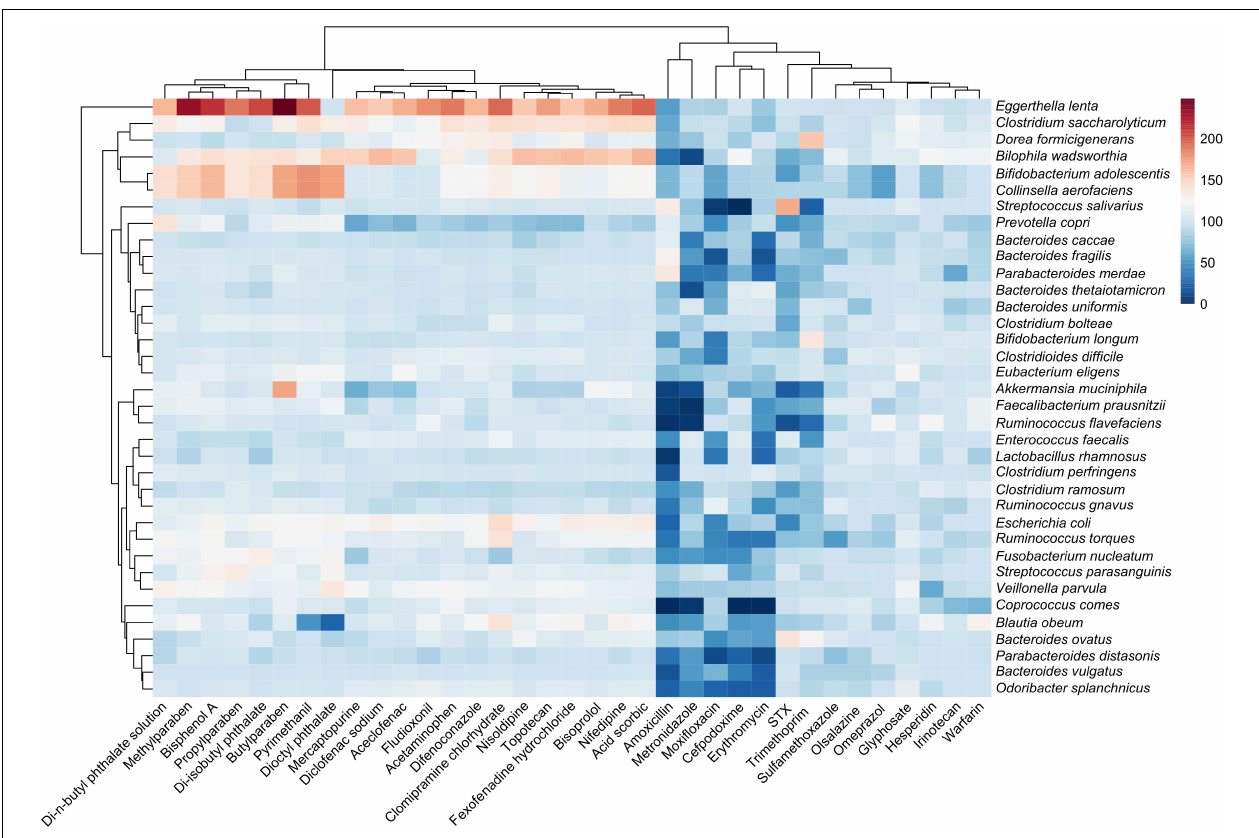
FIGURE 6 | Sensitivity of each strain constructing the HGMM to antibiotics, drugs and xenobiotics in individual cultures. The growth percentage of each strain (exception with C. leptum , R. intestinalis, and R. bromii ) in the presence of a molecule was calculated from the control cultures without this molecule. Boscalid was not tested on individual strains. The color code indicates the growth percentage for each strain ranging from blue (no growth) to red (increased growth). The clusterization of strains (on the left) was based on their sensitivity to the tested molecules (not on a taxonomic relationship). The clusterization of the molecules (on the top) was based on their effect on the growth of the